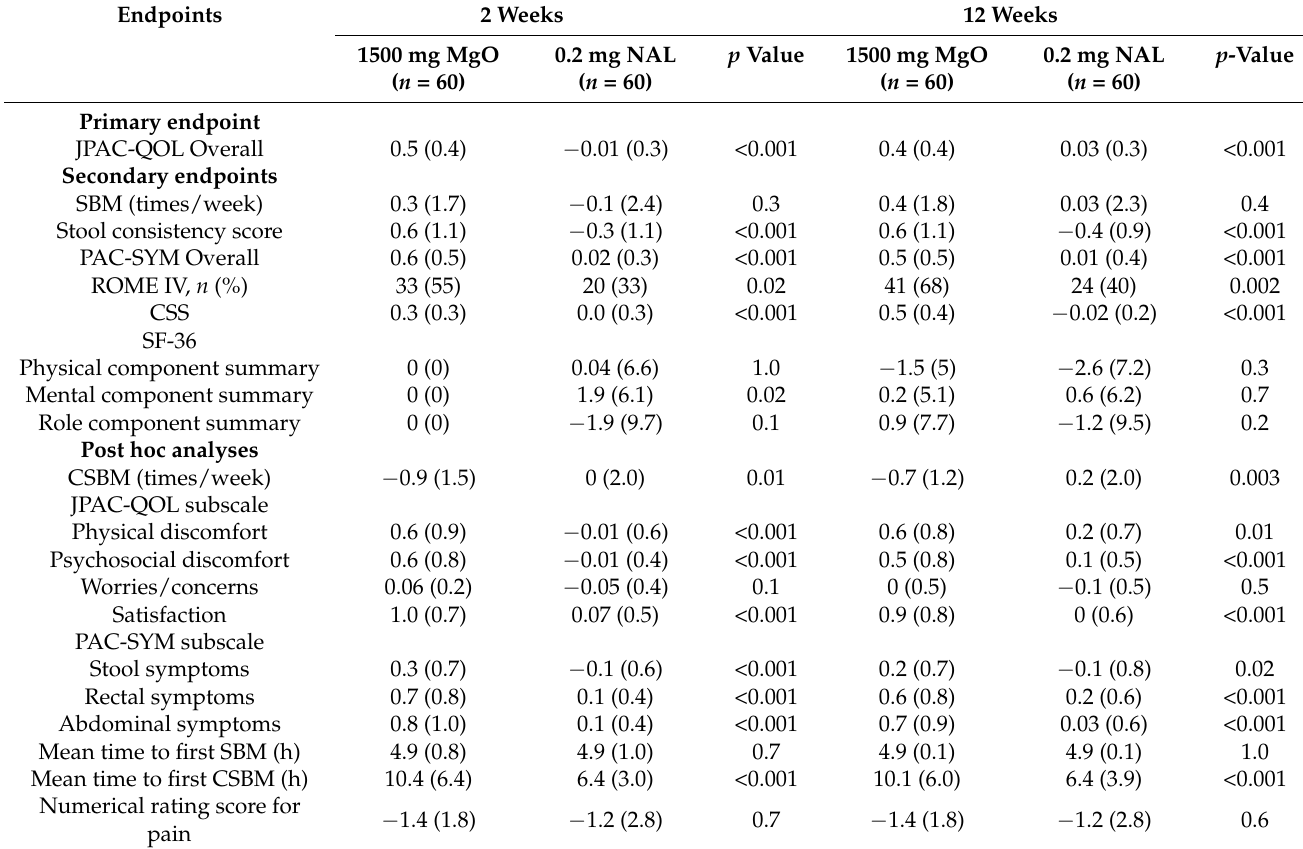
Figure 4. ( A ) Change in the Japanese version of Patient Assessment of Constipation Quality of Life (JPAC-QOL) subscale score at baseline and after 2 weeks of treatment in the magnesium oxide (MgO) group and naldemedine (NAL) groups; ( B ) change in the JPAC-QOL subscale score at base- line and after 12 weeks of treatment in the MgO group and NAL groups; ( C ) change in the Patient Assessment of Constipation Symptoms (PAC-SYM) subscale score at baseline and after 2 weeks of treatment in the MgO group and NAL groups; and ( D ) change in the PAC-SYM subscale score at baseline and after 12 weeks of treatment in the MgO group and NAL groups.